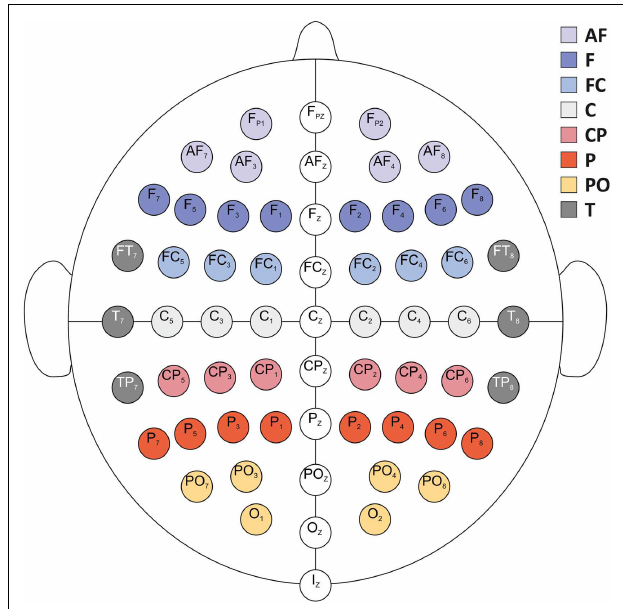
FIGURE 2 | Schematic display of EEG electrode positions. For statistical analyses, %ERS/ERD was aggregated over eight areas per hemisphere (electrode positions given exemplarily for the left hemisphere): anteriofrontal (AF; Fp1, AF7, AF3), frontal (F; F7, F5, F3, F1), frontocentral (FC; FC5, FC3, FC1), central (C; C5, C3, C1), centroparietal (CP; CP5, CP3, CP1), parietal (P; P7, P5, P3, P1), parietooccipital (PO; PO7, PO3, O1), and temporal (T;